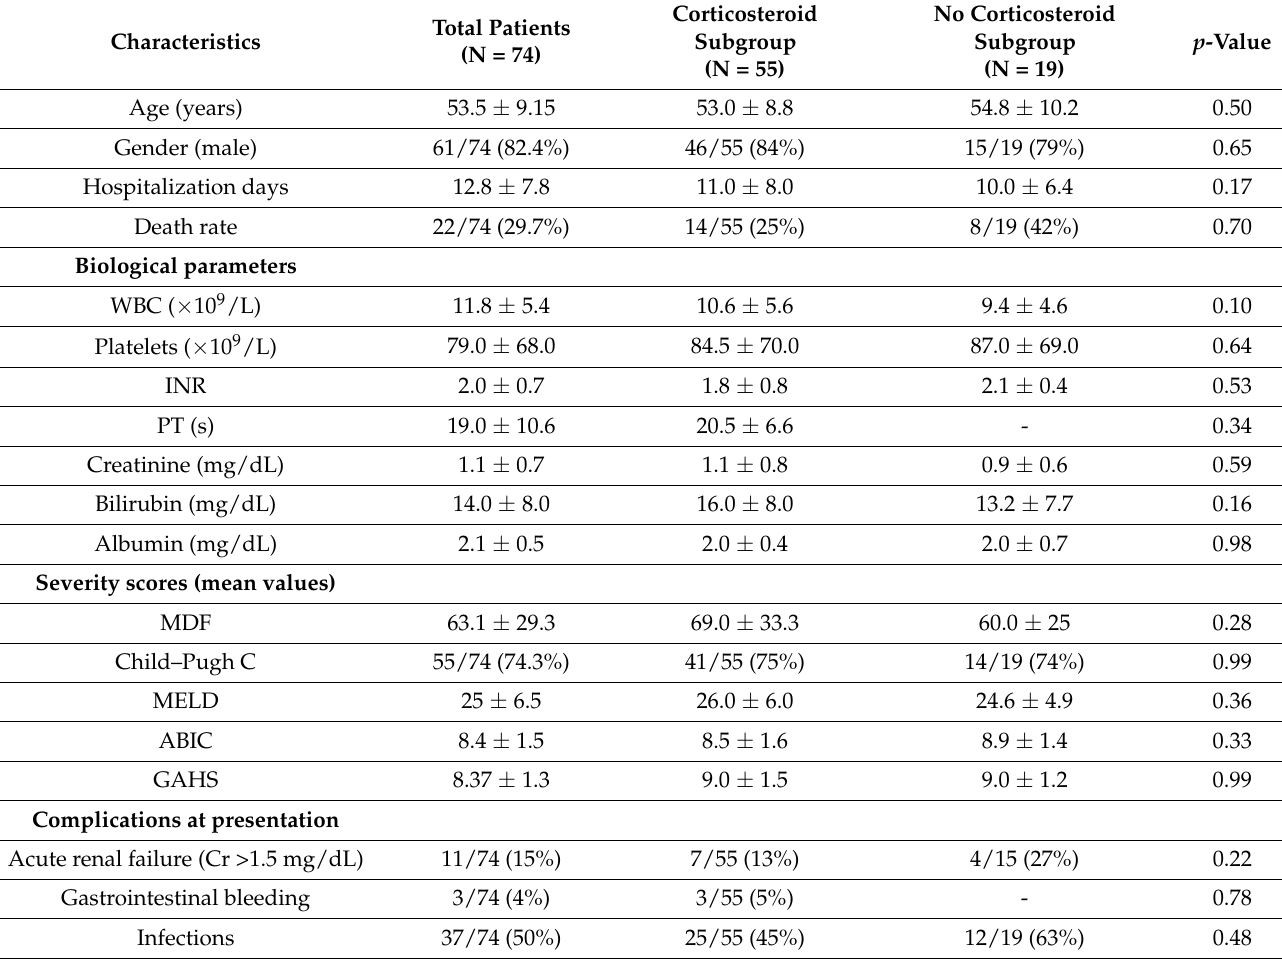
Table 1. Patient